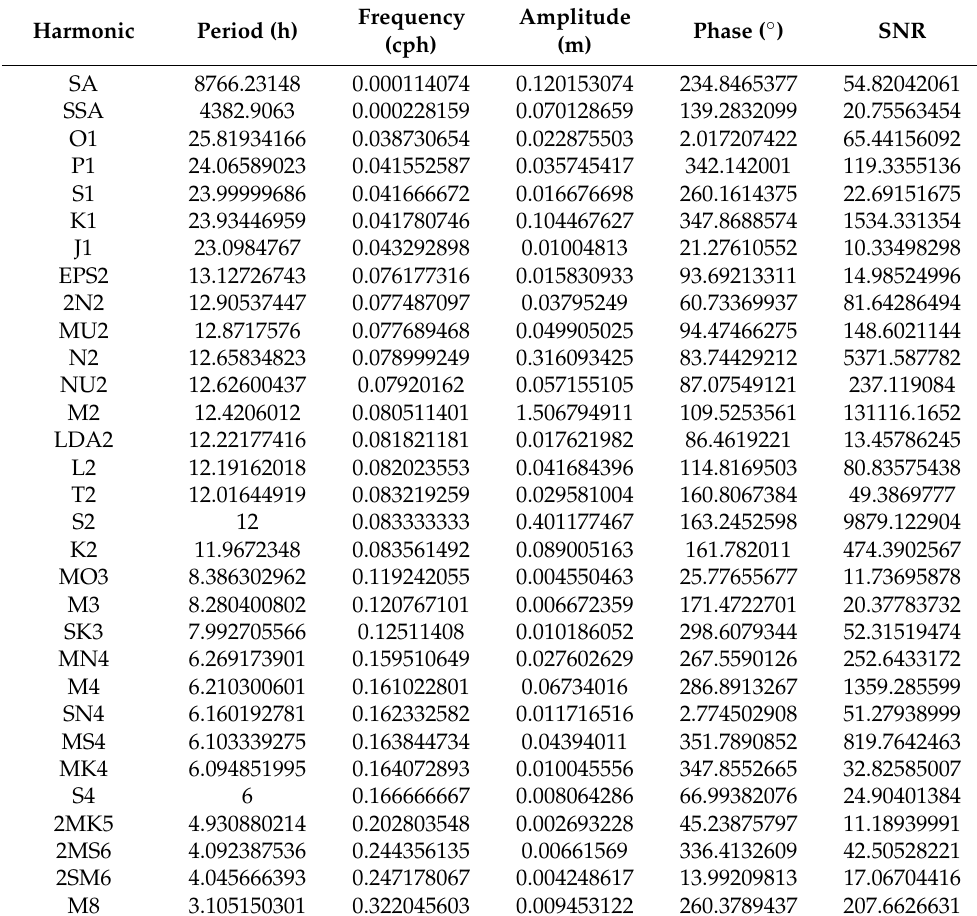
Table 2. Main constituent tidal harmonics of Buenaventura Bay calculated from measured water level data between 2011 and